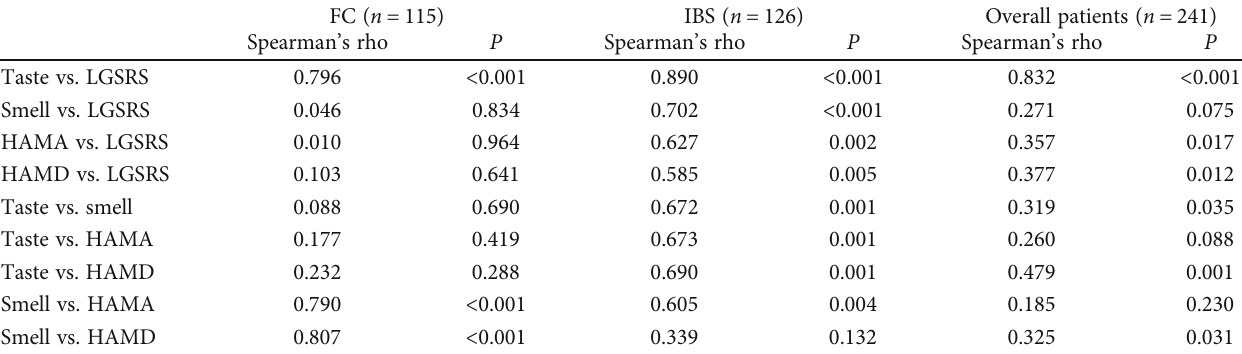
Table 3: Correlation among taste, smell, HAMA, HAMD, and LGSRS scores for functional constipation and irritable bowel syndrome patients.